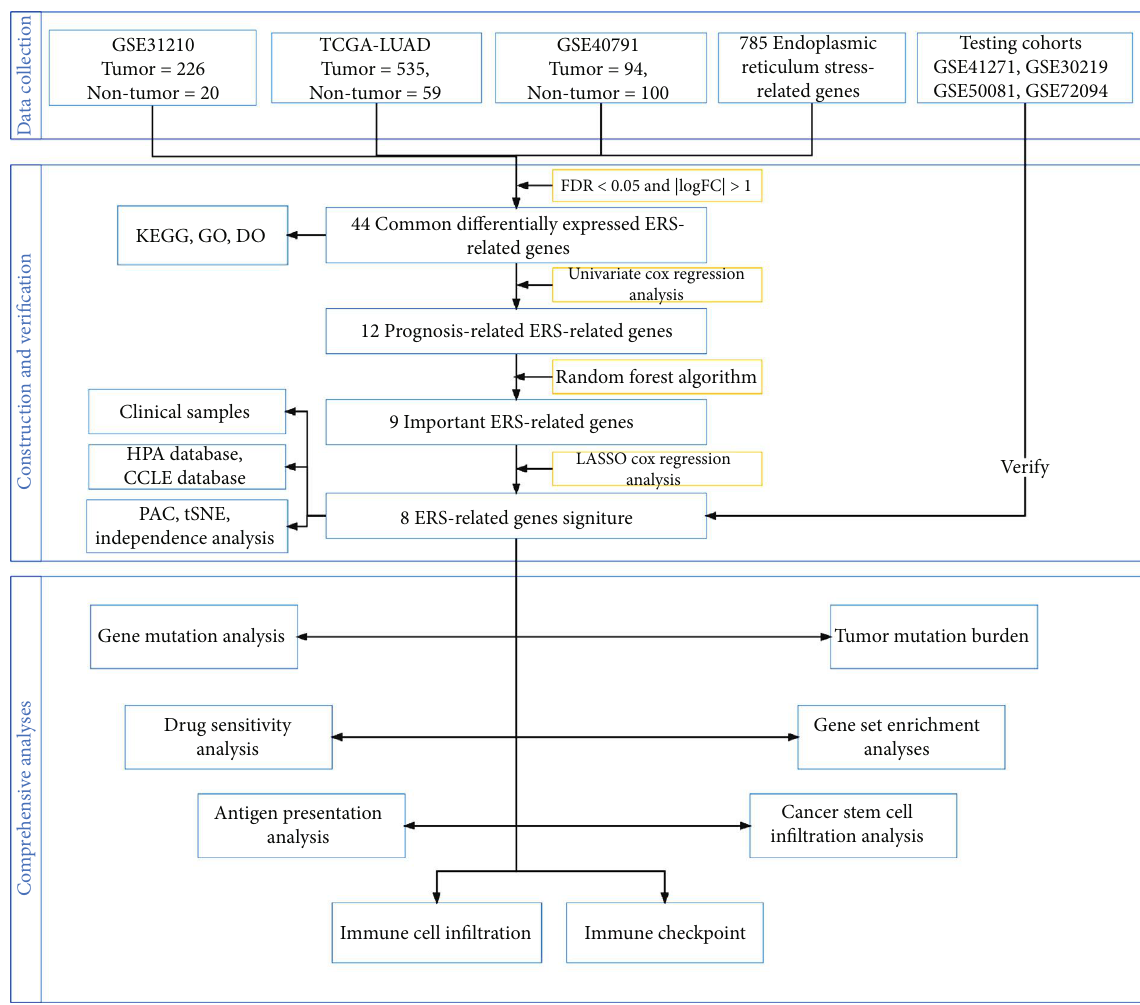
Figure 1: The research process of this